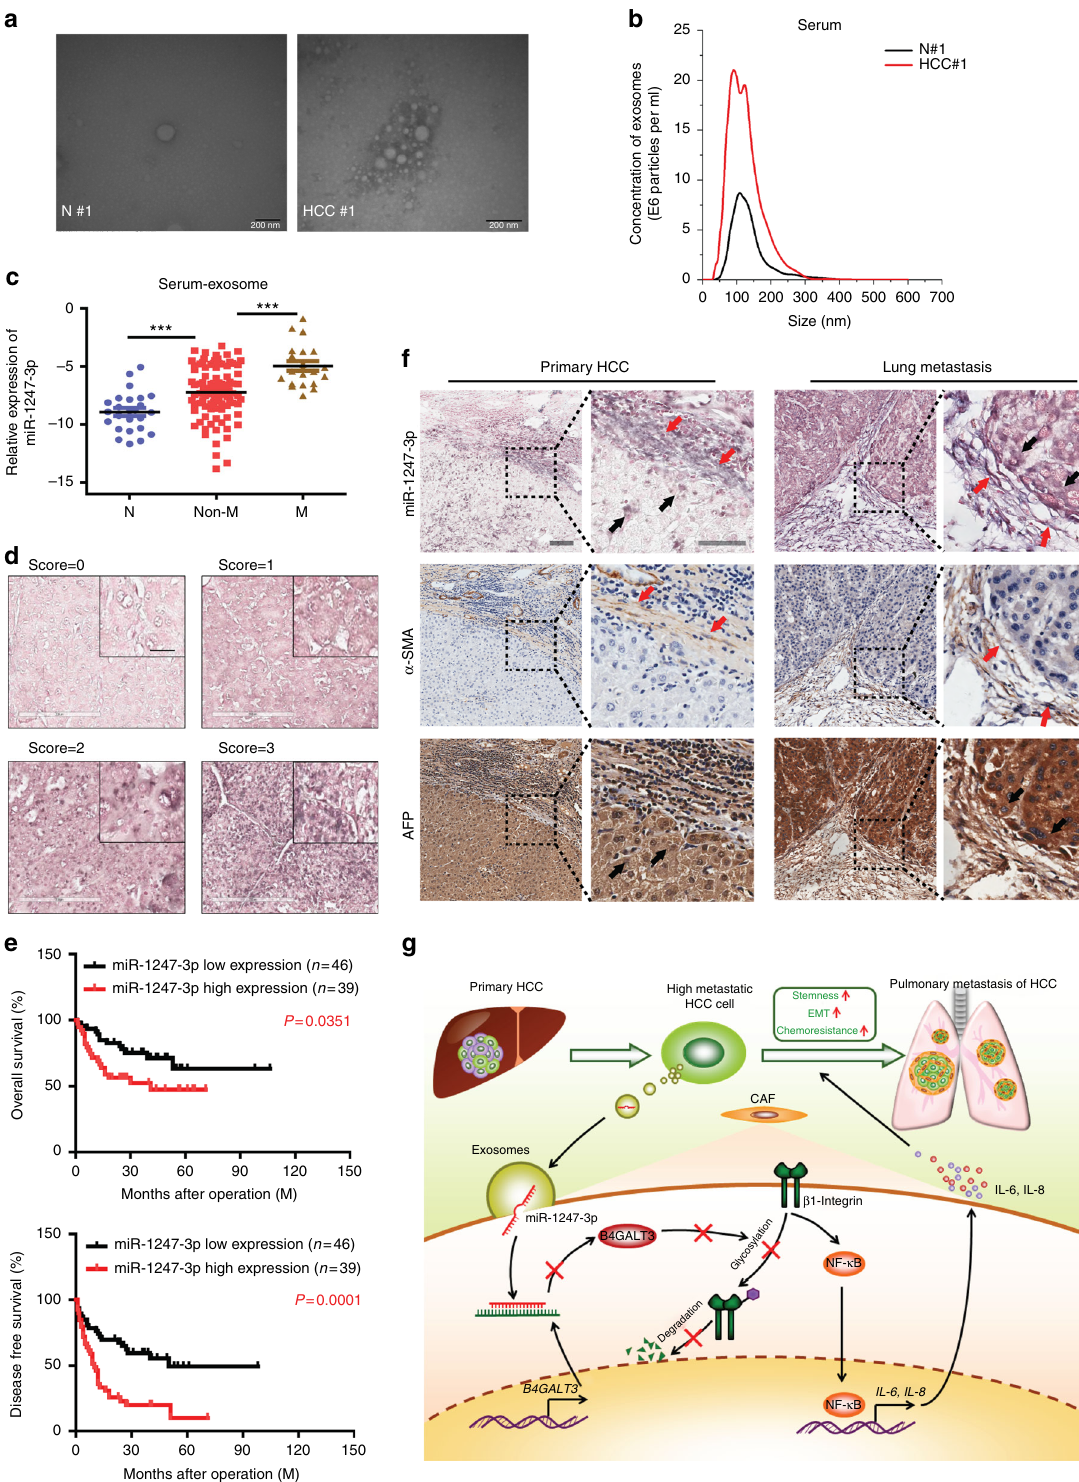
Fig. 6 MiR-1247-3p is associated with lung metastatic progression in liver cancer. a , b Exosomes in normal and HCC serums were detected by electron microscopy and Nanosight particle tracking analysis. Scale bar, 200 nm. c MiR-1247-3p expression level in serum exosomes from healthy donors and primary HCC patients. Non-M, HCC patients without lung metastasis. M, HCC patients with lung metastasis. Data are presented as mean ± s.d. Student ’ s t -test was used to analyze the data. *** p < 0.001. d In situ hybridization assay of HCC samples and scores of miR-1247-3p level. Representative images were shown. Scale bar, 50 μ m. e Kaplan – Meier plots of overall survival and disease-free survival of 85 patients with HCC, strati fi ed by expression of miR- 1247-3p. Survival data were analyzed by the Kaplan − Meier method and log-rank test. f In situ hybridization of miR-1247-3p in combination with IHC staining of HCC markers (AFP) and fi broblast markers ( α -SMA) on serial sections of human HCC tissues and lung metastatic tissue samples. Red arrows indicated fi broblasts; black arrows indicated tumor cells. Scale bar, 100 μ m. g Proposed schematic diagram of tumor exosomal miR-1247-3p-mediating fi broblasts activation to promote lung metastasis of liver